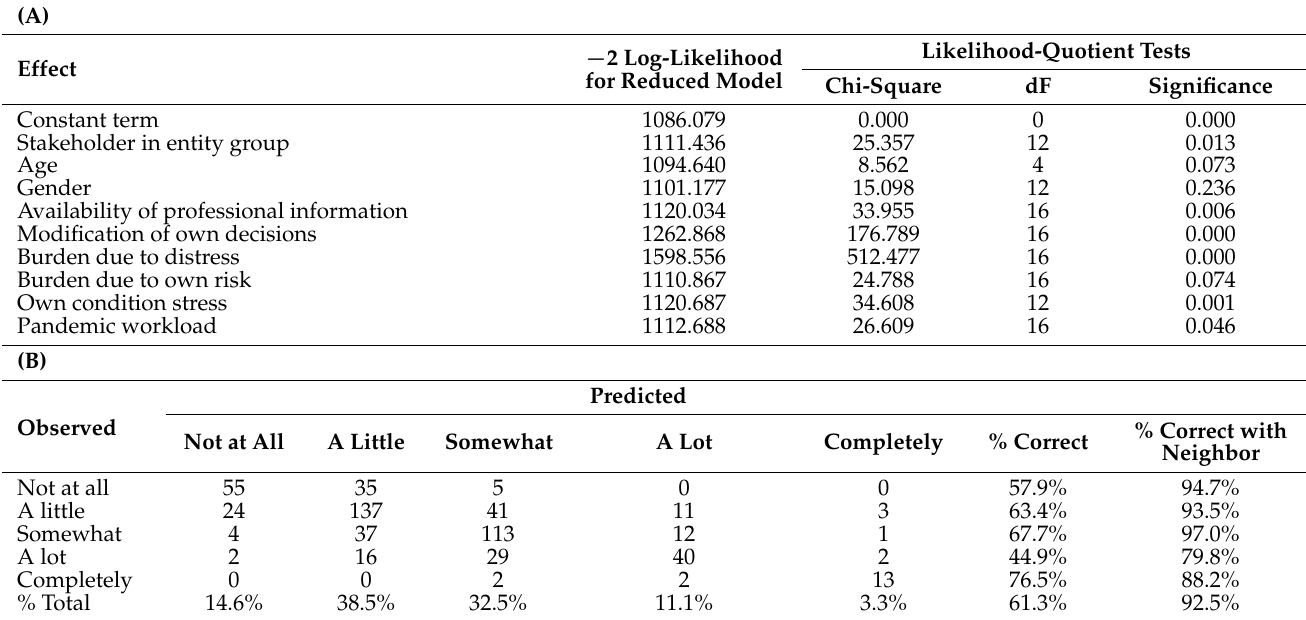
Table 2. Prediction by nominal regression analysis for “Decisional Uncertainty”: (A) Likelihood– Quotient Test for regression parameters and (B) resulting classification.